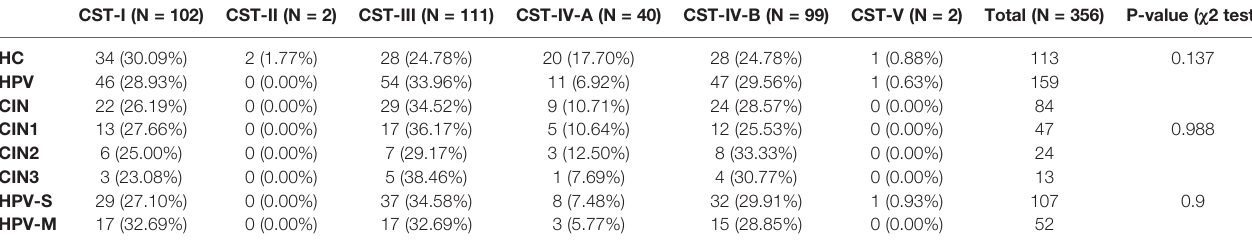
TABLE 1 | The characteristics of all included